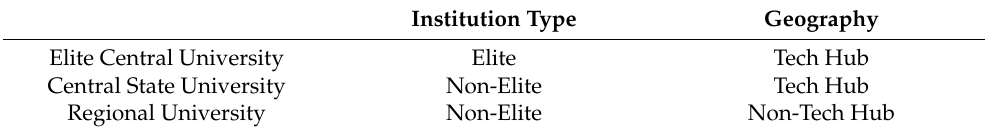
Table 1. Universities by institution type and